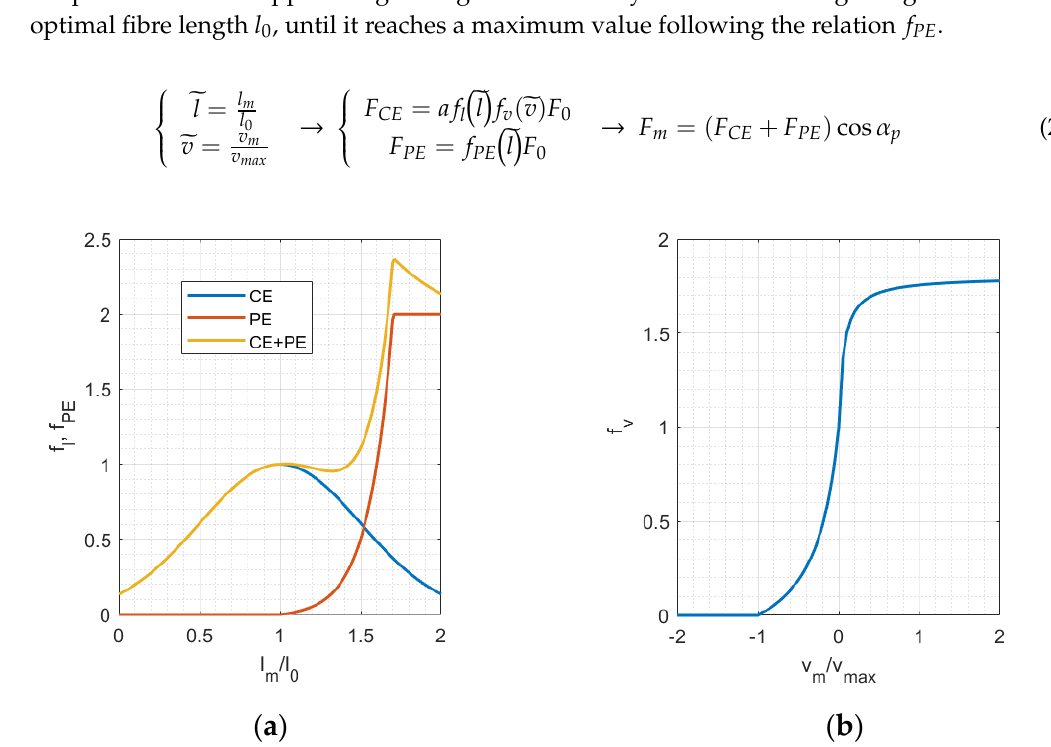
Figure 4. Hill model force–length ( a ) and force-velocity ( b ) curves.